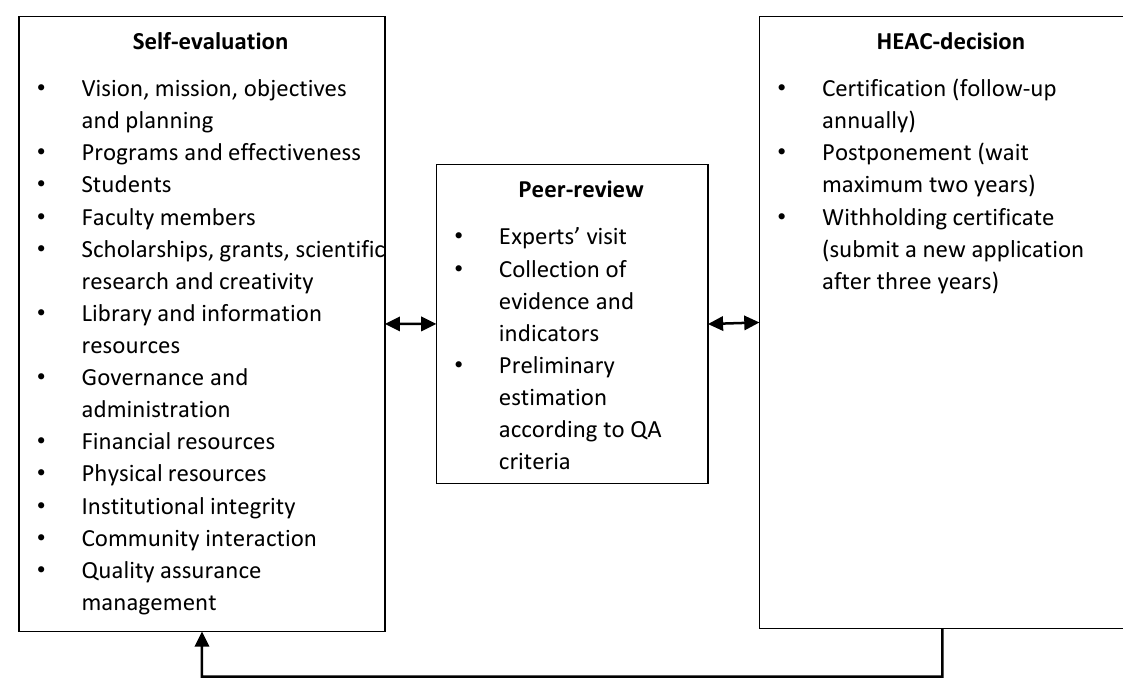
Figure 2. Quality assurance system